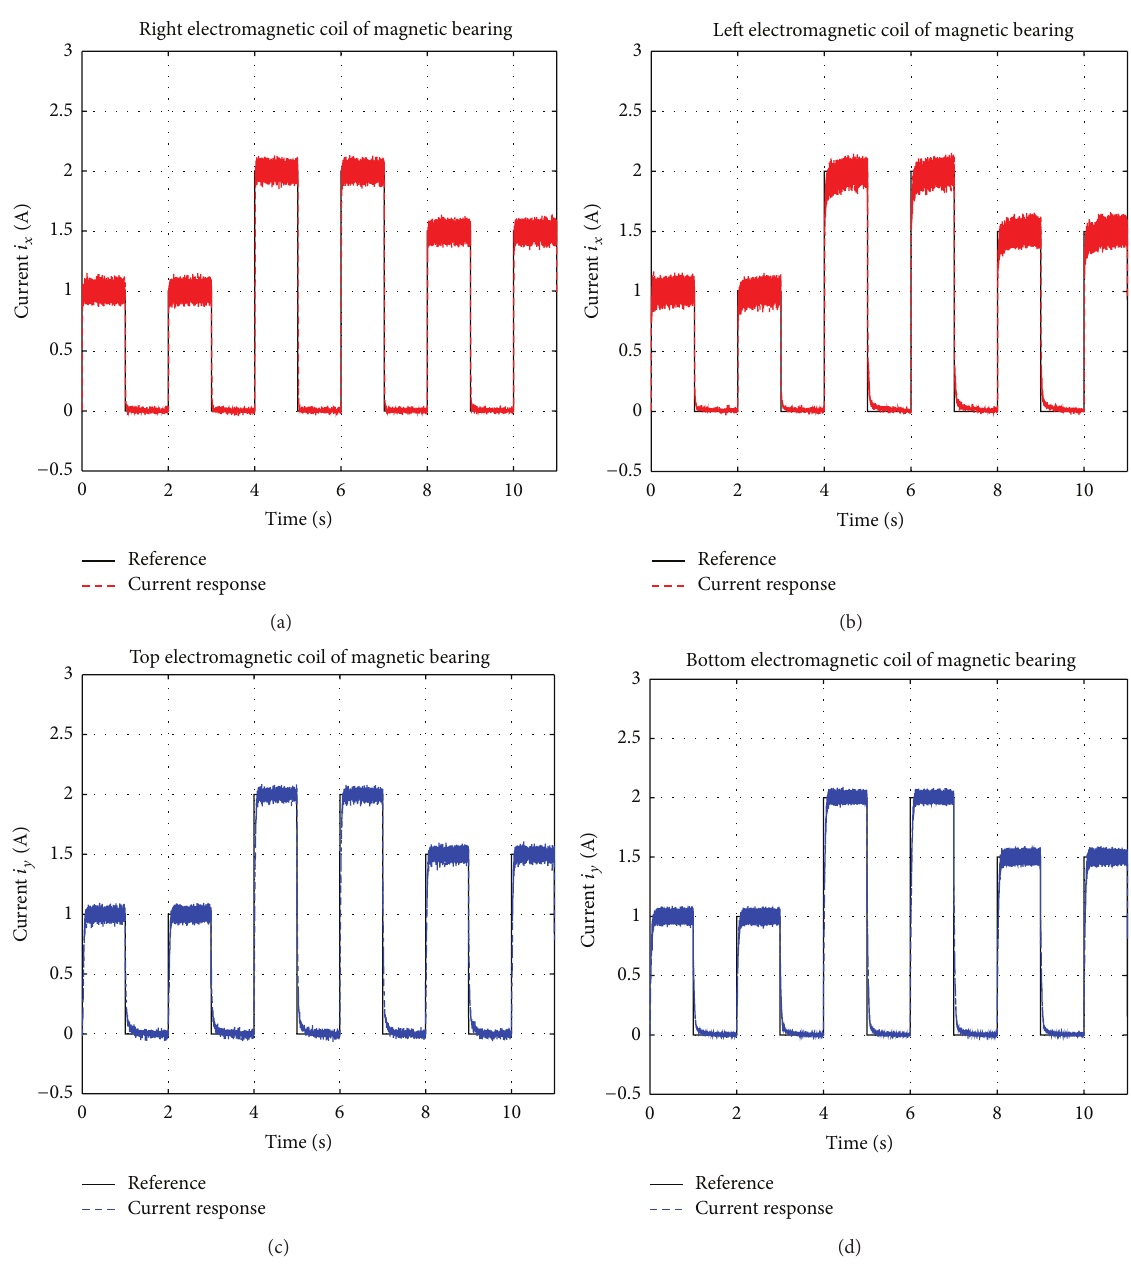
Figure 18: Current loop control of magnetic bearing with 𝑥 - and 𝑦 -axes.